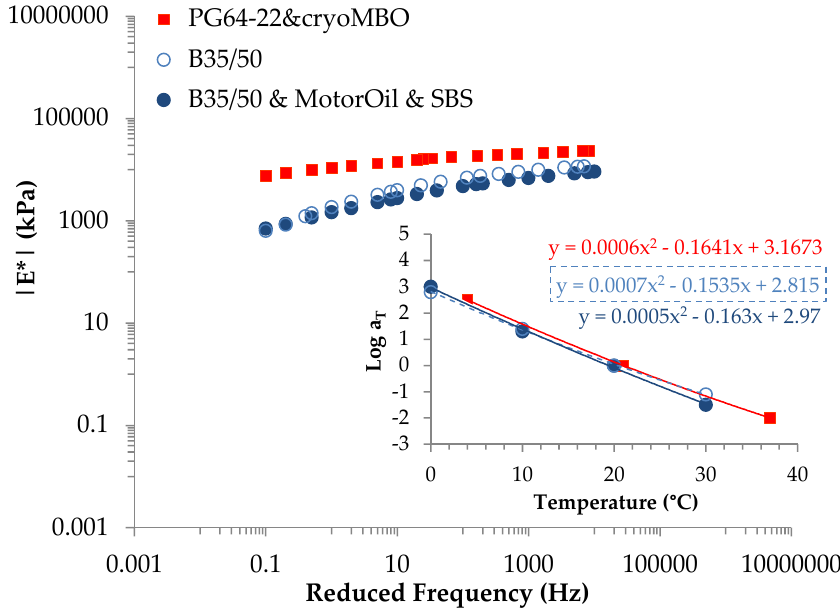
Figure 4. Master curves of the shifted dynamic stiffness modulus for the different asphalt mixtures (T ref = 21 °C) studied in this work (the insert represents the quadratic fitting of the shift factors obtained using the Arrhenius time ‐ temperature superposition principle).